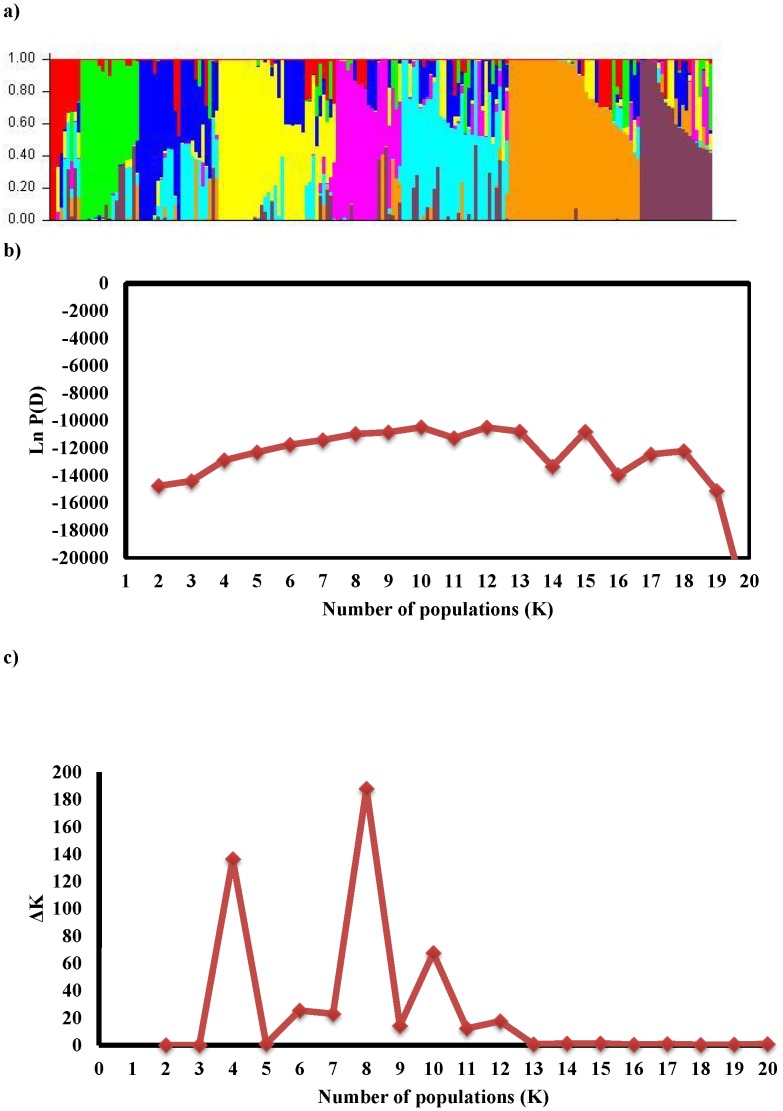
Estimation of number of sub-populations (K) in synthetic hexaploid wheat based on unlinked SNP markers.
a) Population structure of synthetic hexaploid wheats. The genotype of each line on the figure is represented by a colored line where each color reflects the membership of a cultivar in one of the K clusters. The proportion of the colored segment indicates the proportion of the genome drawn from the K clusters. b) The log probability of data as a function of K for unlinked SNP markers. Means log probability of data Ln P (D) for each value of K were calculated from 10 independent runs of structure. c) Estimation of number of sub-populations (K) in synthetic hexaploids using deltaK values.